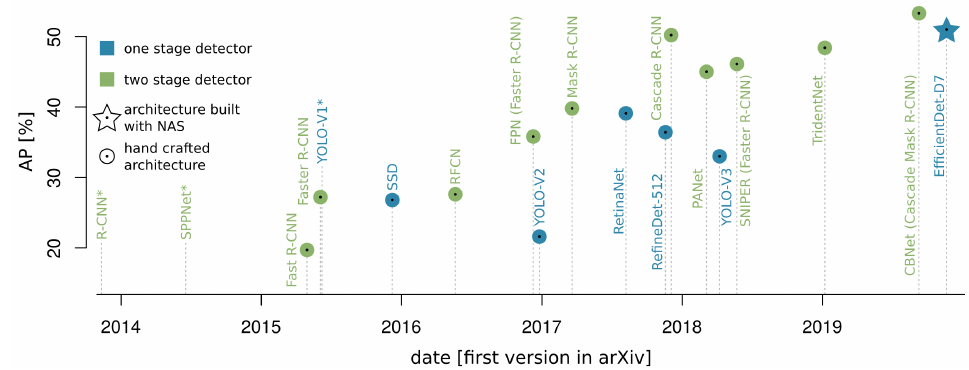
Figure 12. Evolution of milestone architectures for object detection from late 2013 to 2019, compared by their average precision (AP) metric on the MS-COCO test-dev set for object detection. Architectures marked with an * are tested on different datasets and no metric on MS-COCO test-dev set is